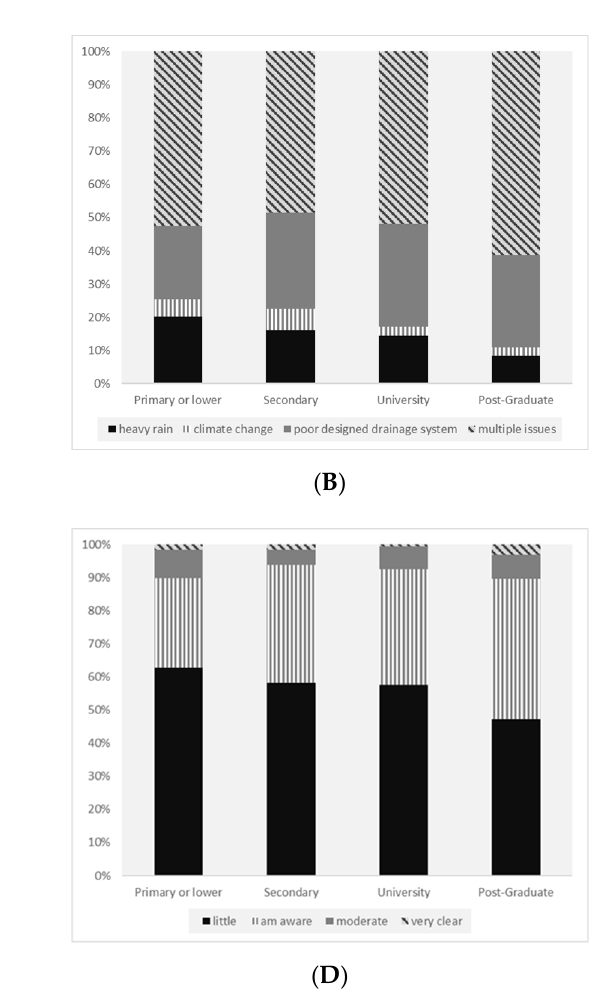
Figure 2. Cross-analyses between education level and survey questions: ( A ) the awareness of the severity of flood in Wuhan; ( B ) the perception of the causes of flood; ( C ) the perception of governmental efforts in flood control; ( D ) the awareness of Sponge City projects.